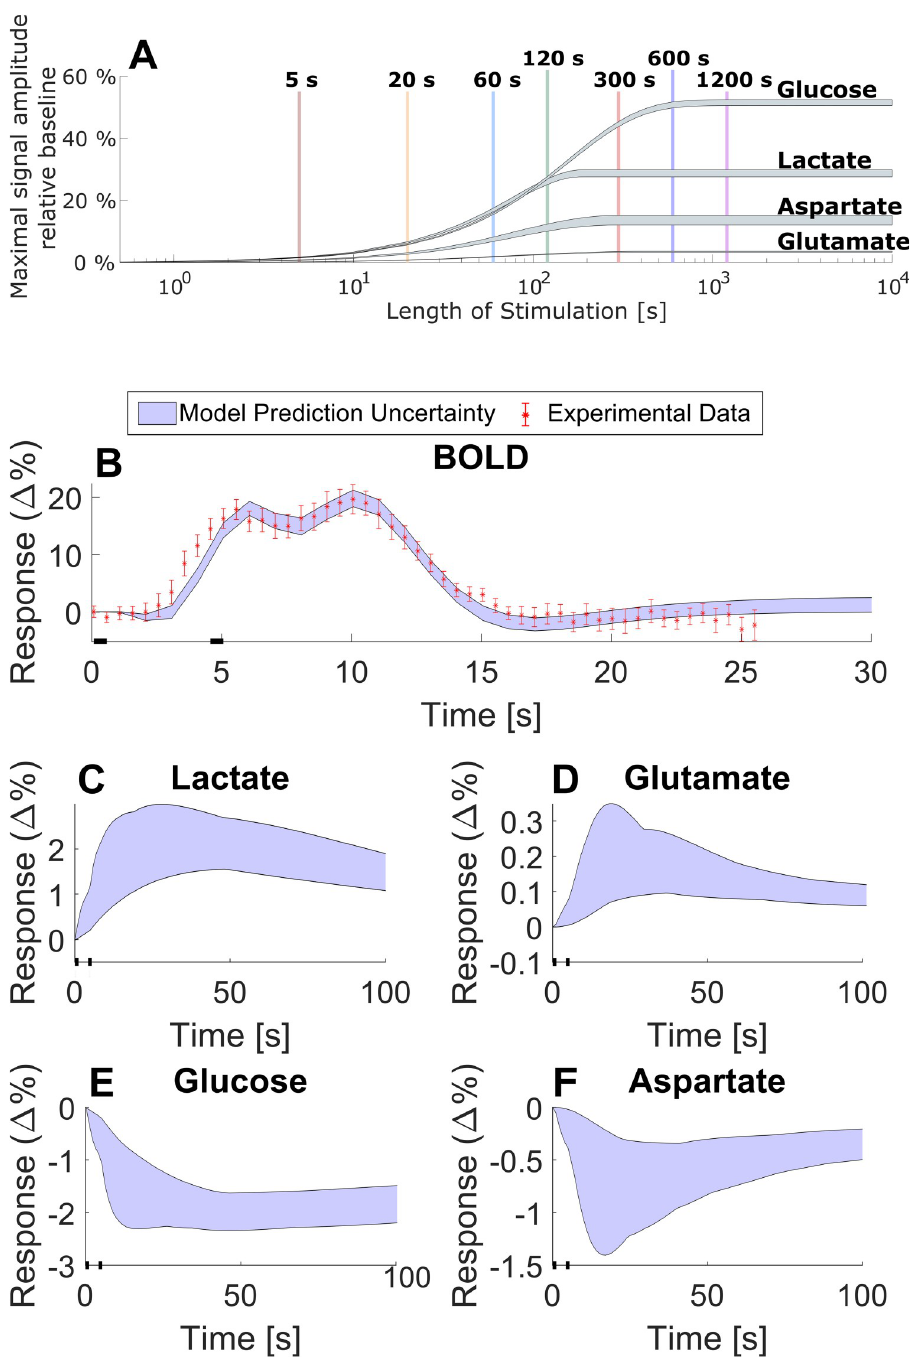
Fig 6. Examples of the type of simulations that are possible to do with the model. A. An illustration of how the maximum amplitude of the metabolic response (grey shaded areas) changes with the length of stimulation. B. Shows a model prediction (blue shaded area) of a BOLD response for two short 0.5 seconds stimuli 4 seconds apart and corresponding data (red error bars). The data is gathered from Lundeng å rd et al. [22]. C-F. shows the model predicted metabolic response to the same short double stimuli. C. shows the metabolic response for lactate; D. for glutamate; E. for glucose; and F. for aspartate.